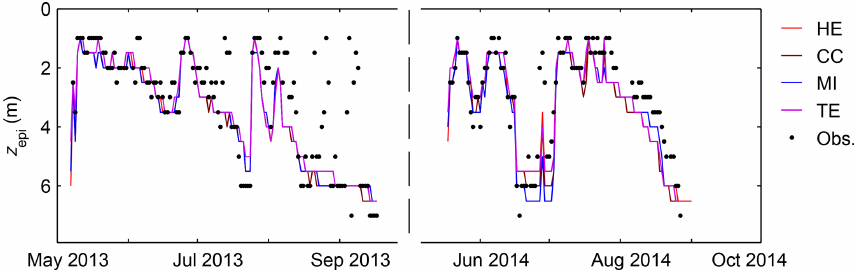
Figure 6. Simulated and observed depths of the epilimnion (m) in Lake Kuivajärvi during the continuous summer stratification in 2013 and 2014. The simulations were performed using each of the gas exchange models incorporated into MyLake